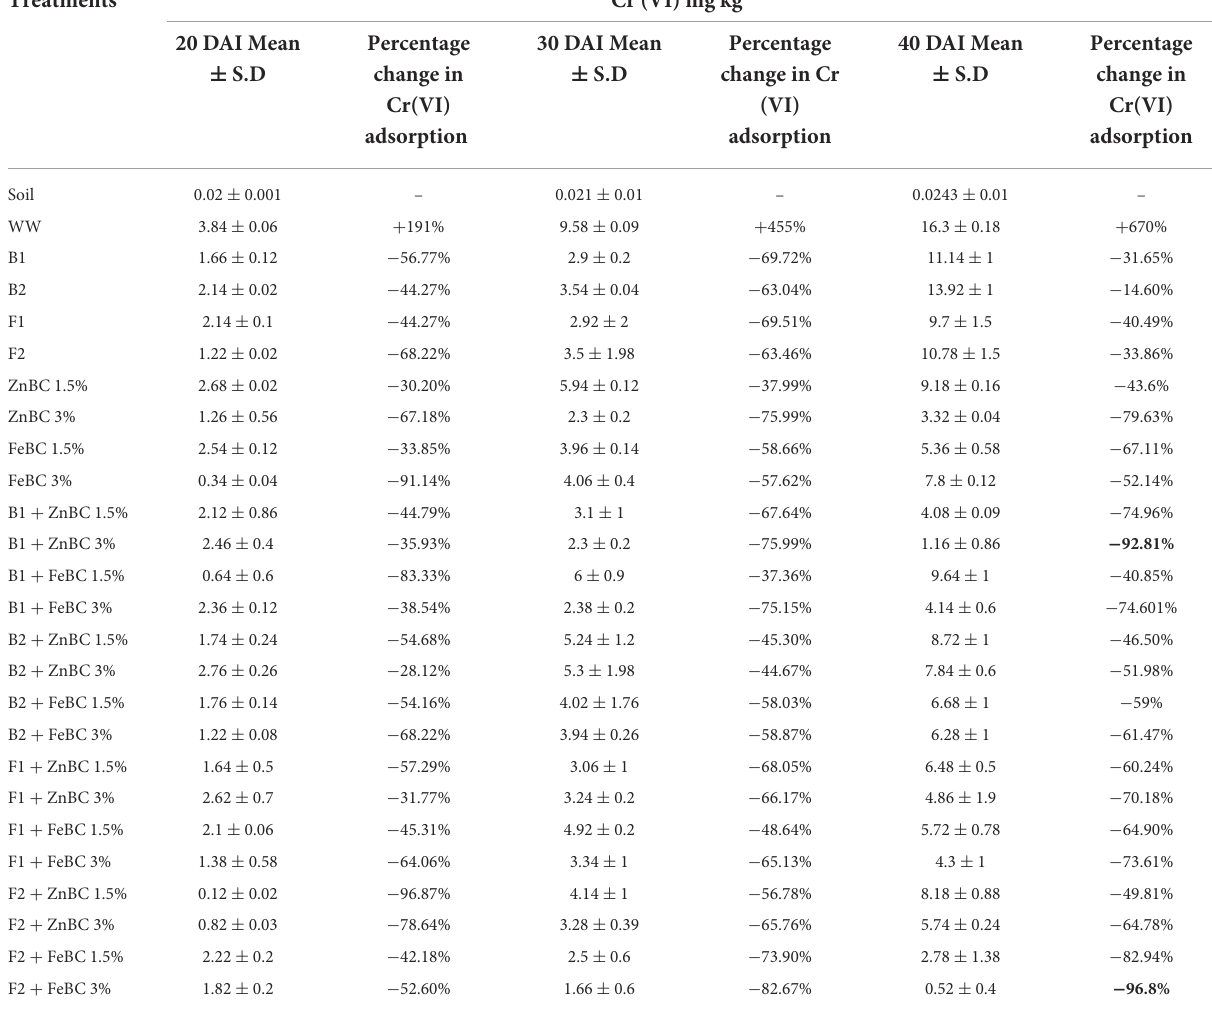
TABLE 3 Percentage (%) change in metal adsorption (R = 3 mean) after 20, 30, and 40 days of soil metal-spiking.